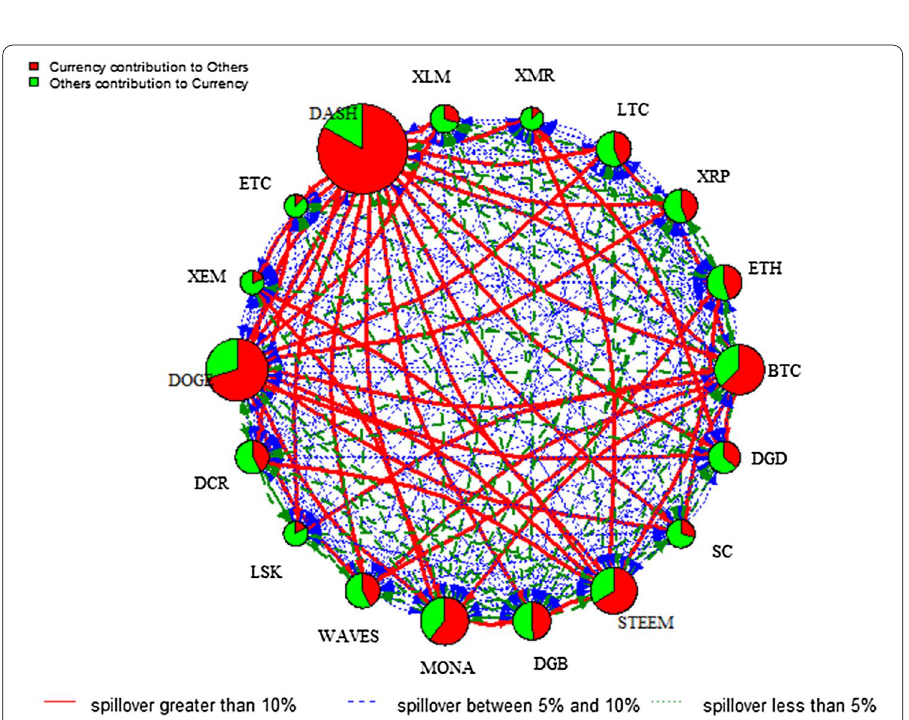
Fig. 8 DY Spillover network—high volatility regime of COVID19. Note : See notes to Fig.